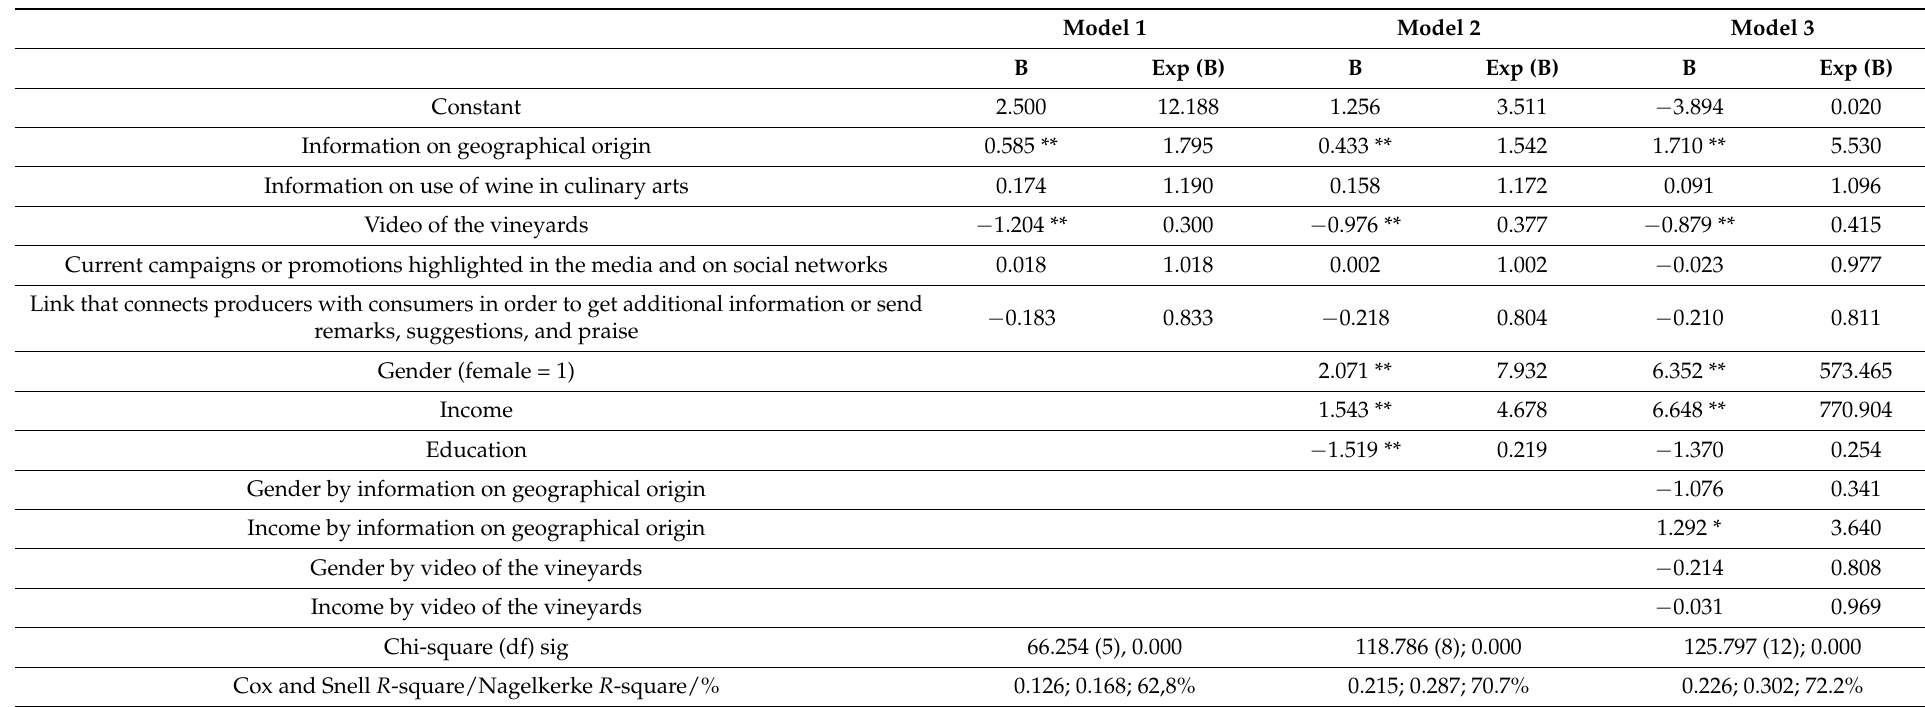
Table 5. Logistic regression for Generation